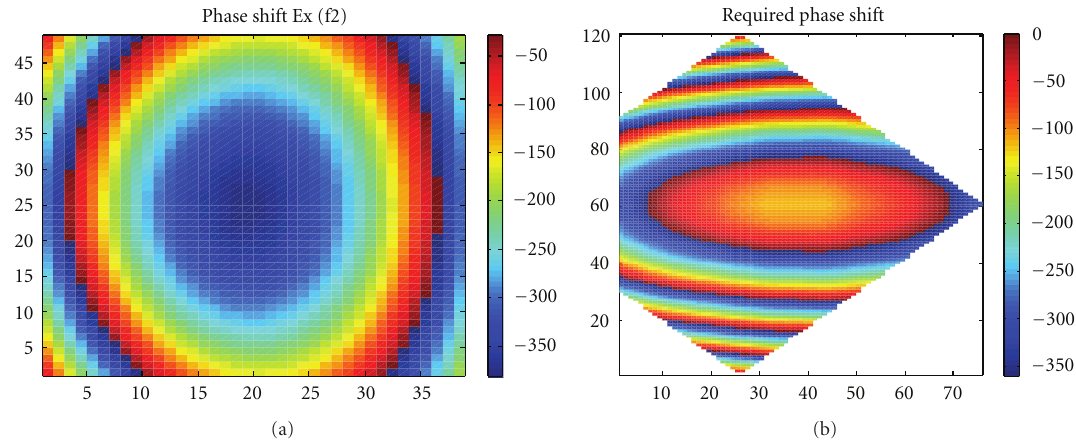
Figure 5: Phase distribution to be implemented on the subreflectarray (a) and on the main reflectarray at 12.75 GHz